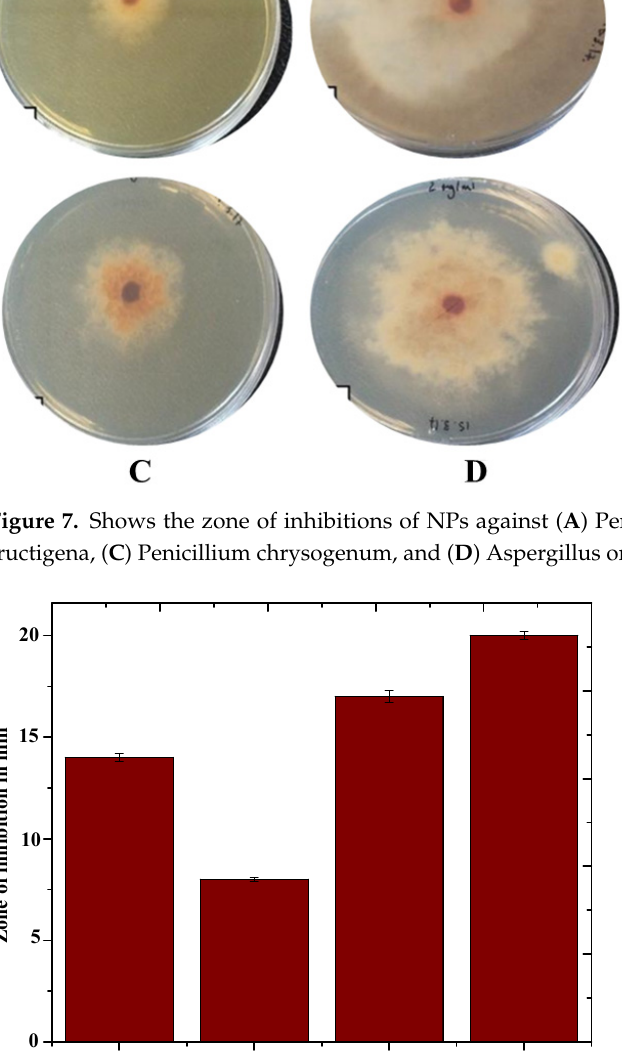
Figure 8. Anti-fungal potential of MnO 2 NPs against spoil-causing fungal isolates.